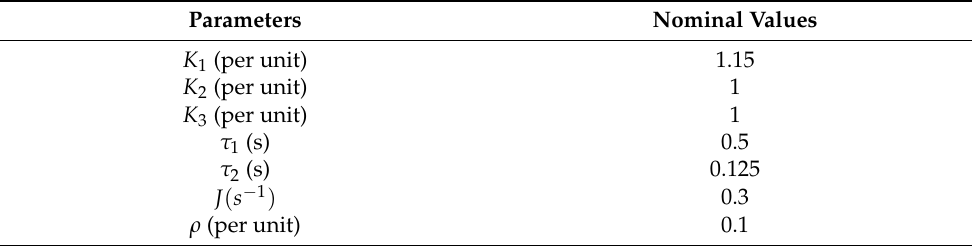
Table 1. System parameters of a typical diesel engine